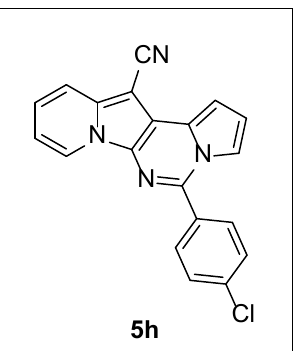
5-(4-Chlorophenyl)pyrrolo[1 (cid:48) ,2 (cid:48) :1,6]pyrimido[5,4- b ]indolizine-12-carbonitrile (5h). Yellow solid, m.p.: 230.0–230.8 9 ◦ C (27.5 mg, 73%); 1 H NMR (400 MHz, CDCl 3 ) δ 8.71 (d, J = 6.8 Hz, 1H), 7.87 (d, J = 7.2 Hz,